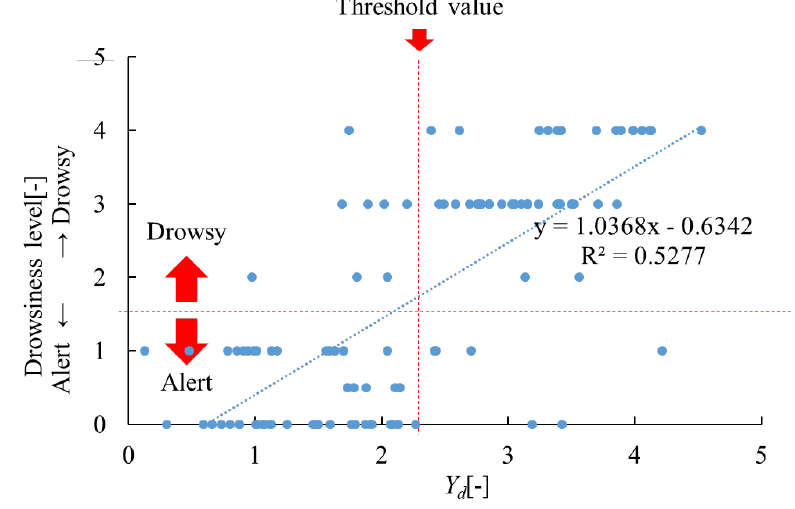
Figure 12. Setting of the threshold value in relation to Yd.